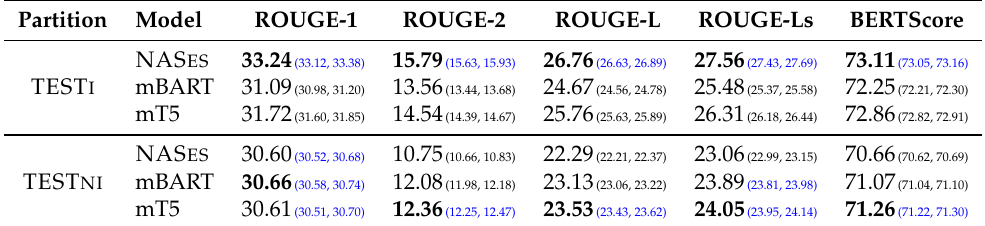
Table 7. Average F1 scores and confidence intervals of models in summarization task in Spanish. Partition